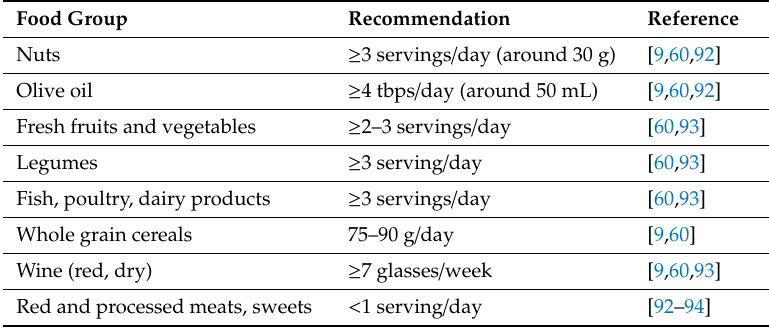
Table 2. Dietary recommendations according to the Mediterranean diet.